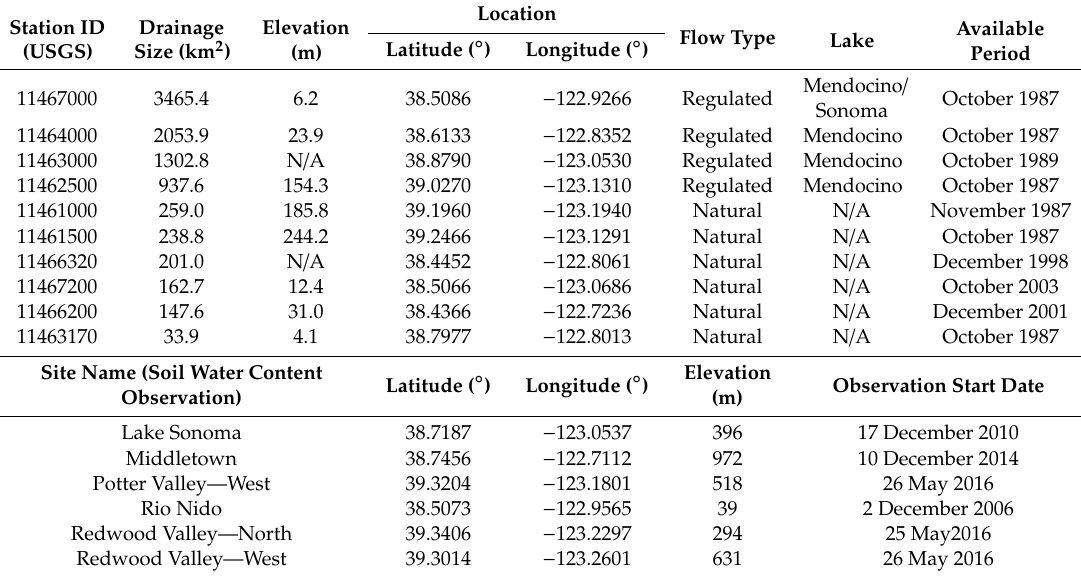
Table 2. United States Geological Survey (USGS) stream gauges and soil water content observation sensors used in this study. ID—identifier; N / A—not